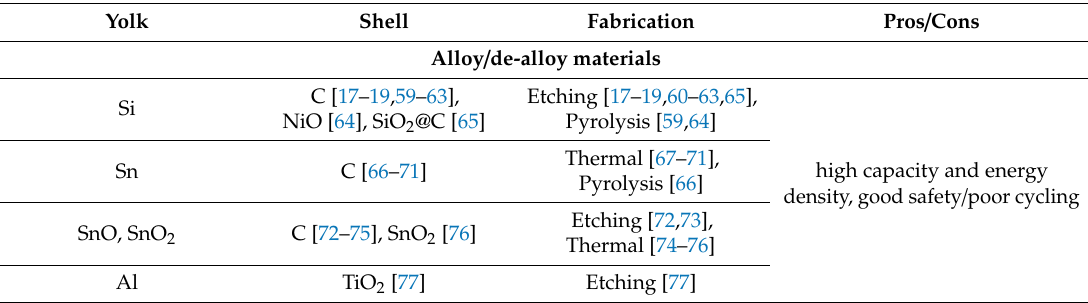
Summary of various Li / Na rechargeable anode materials constructed as yolk–shell nanostructures. (Pyrolysis: spray pyrolysis , Thermal: thermal treatment, Ripening: Ostwald ripening, LTO: Li 4 Ti 5 O 12